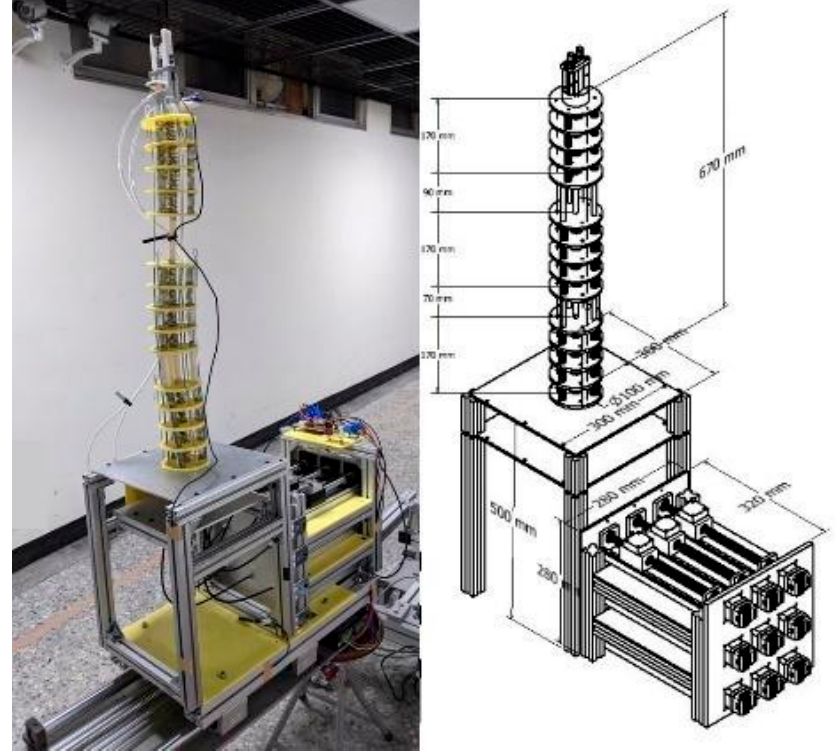
Figure 1. The proposed flexible manipulator with three connected